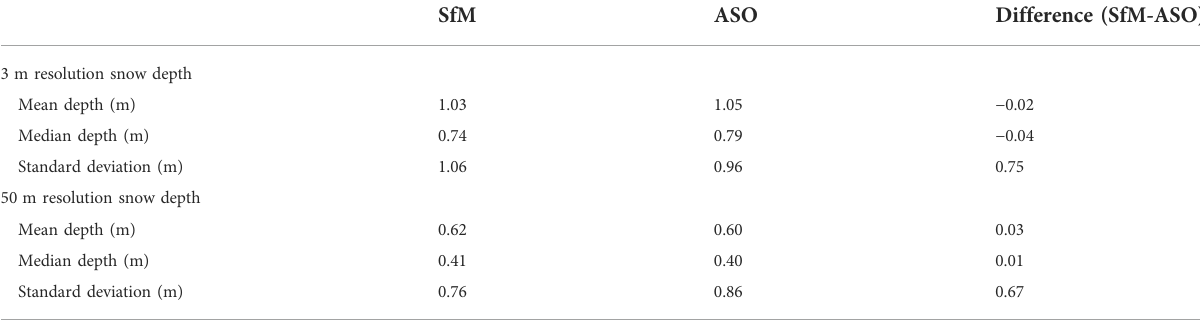
TABLE 2 Overview of snow depth statistics between the 3 m and 50 m output resolutions. SfM ASO Difference (SfM-ASO)